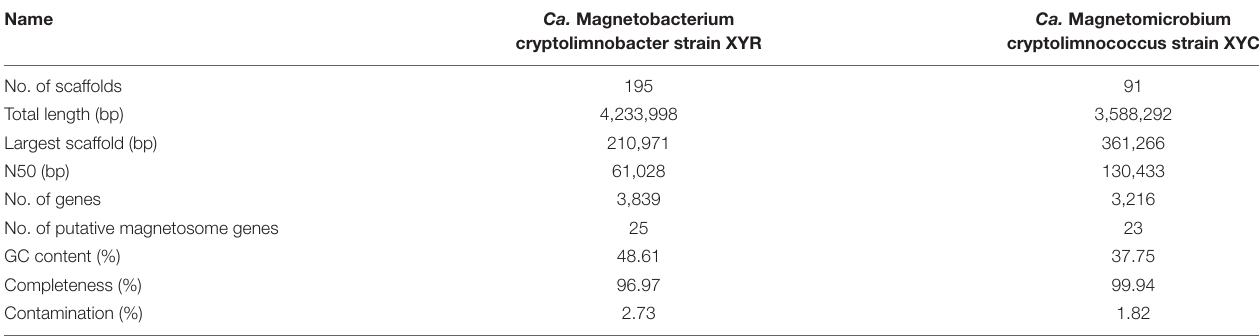
TABLE 1 | Genome statistics of Ca. Magnetobacterium cryptolimnobacter strain XYR and Ca. Magnetomicrobium cryptolimnococcus strain